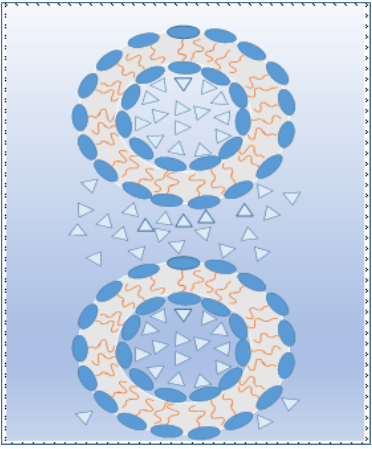
Figure 6. Schematic representation of formation of micellar, rod-like, or disc-like bilayers by prevailing hydro-repulsion. The symbols “ ∆ ” denominate water molecule O < HH .